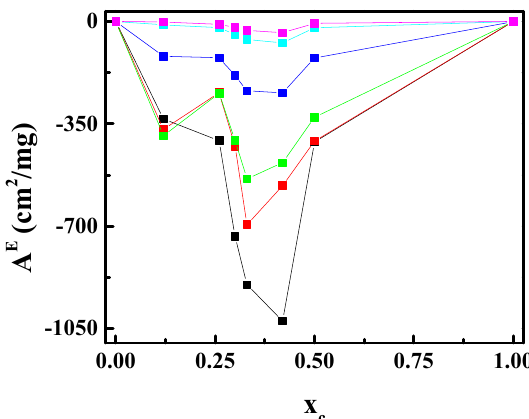
Figure 6. Dependences of the A E on the particle weight fraction, x C , for different values of the surface pressure Π : ( ― ■ ― ) 3 mN/m, ( ― ■ ― ) 6 mN/m, ( ― ■ ― ) 7.5 mN/m, ( ― ■ ― ) 10 mN/m, ( ― ■ ― ) 20 mN/m and ( ― ■ ― ) 30 mN/m. Notice that lines are guides for the eyes.